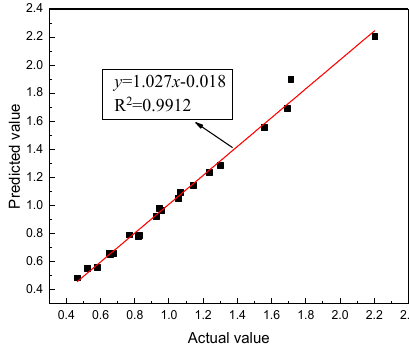
Figure 8. Fitting results of actual value and predicted value.